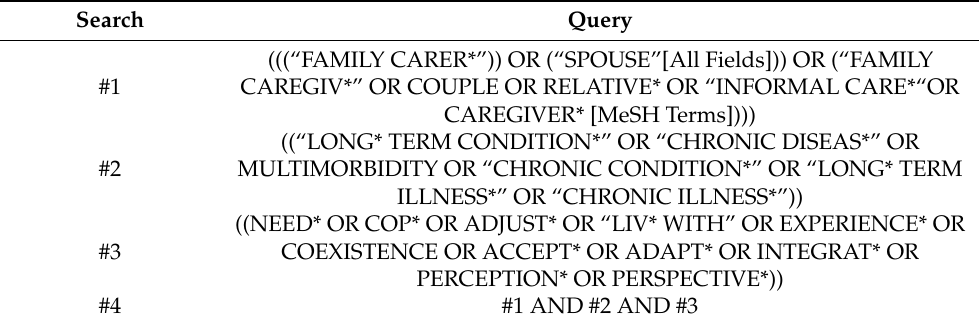
Table 1. Detailed search strategy.